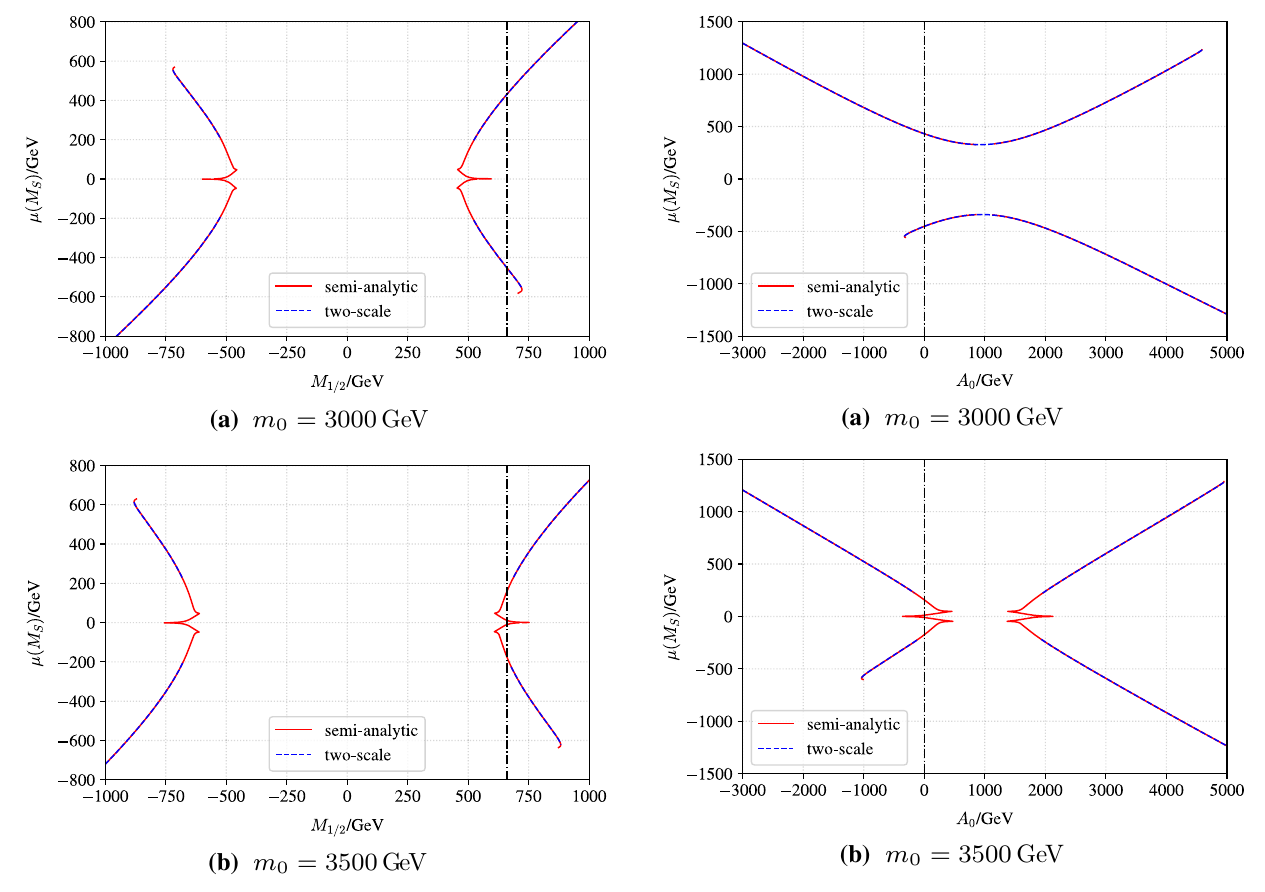
Fig. 9 The relation between M 1 / 2 and μ obtained with the TSS (blue) and the SAS2 (red) for two different values of m 0 . The dash- dotted lines (black) give the points where M 1 / 2 = 660GeV. The intersection points of the colored and the black lines mark the same solutions as the ones shown in Fig.3